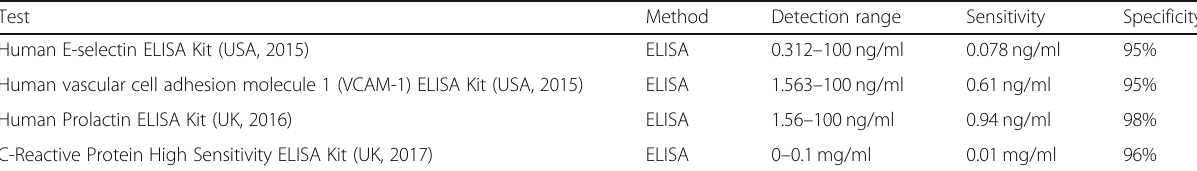
Table 1 Laboratory test